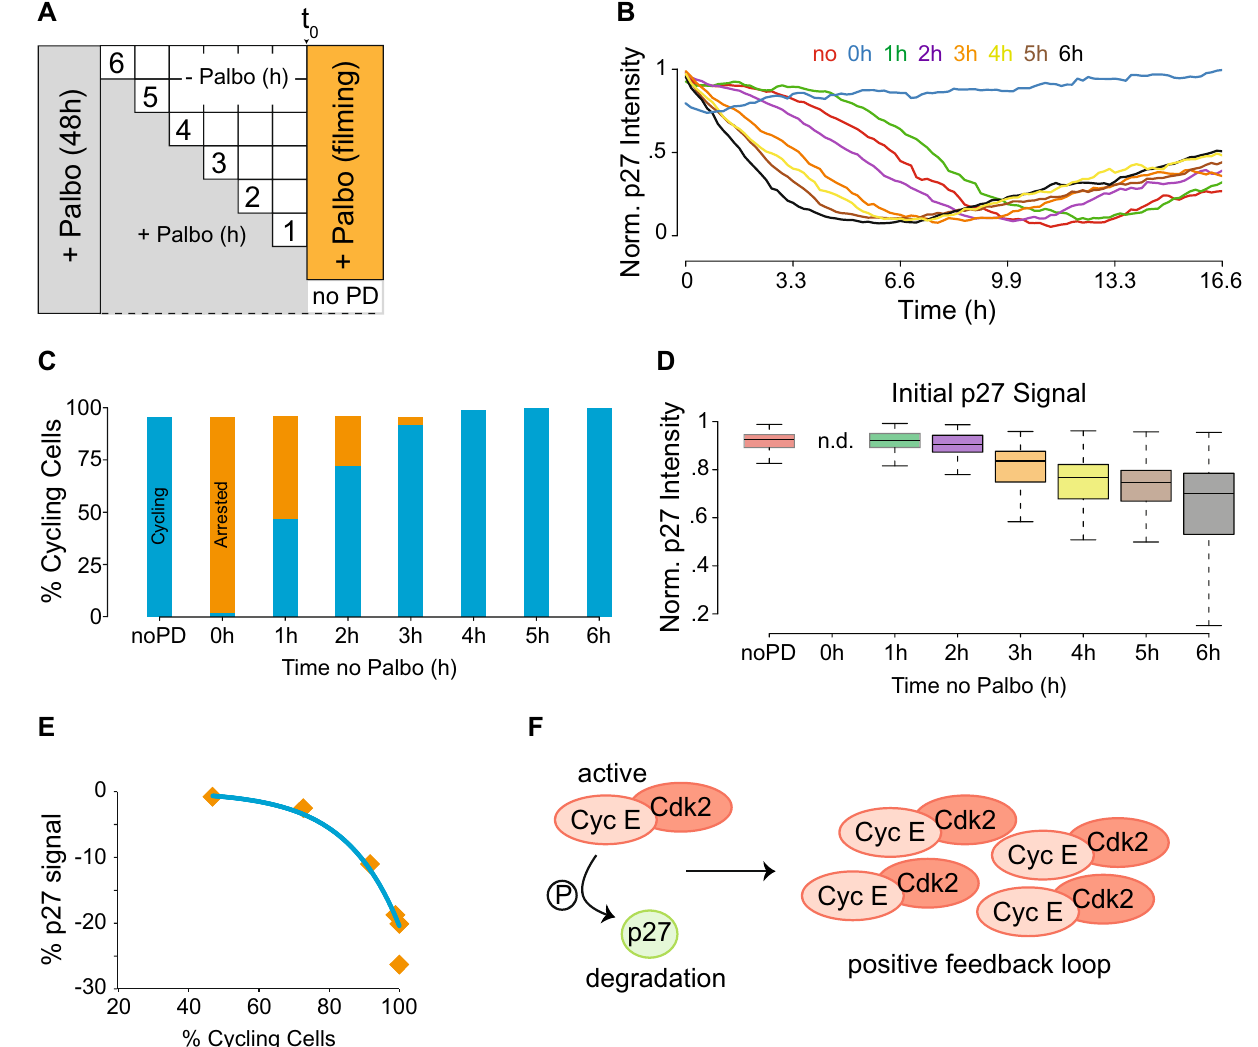
Figure 2. Cyclin D:Cdk4/6 is indispensable after the p27-mCherry inflection point. ( A ) Experimental scheme. In short: p27-mCherry cells were treated for 48 h with Palbociclib before Palbociclib was washed out for the indicated time periods. Before cells were subjected to time-lapse microscopy, fresh Palbociclib was added to all cells but a control sample. Cells were recorded for 20 h, their eGFP and mCherry signals computed to visualize the p27-inflection point. ( B ) An average p27-mCherry signal over 10 time-points for each treated sample is visualized. Note: a time-dependent p27-inflection point is demonstrated. ( C ) Bar graph, grouping all cells from A into cycling (blue) and not cycling or arrested (orange). Interestingly, cells release from 48 h of Palbociclib linearly. ( D ) Box plot visualizing the initial (first 3 time points) p27-mCherry signal intensity of single cells that committed to cellular division (5% increase in H2B-eGFP signal) and its change over time. ( E ) The percentage of cycling cells per time point of no Palbociclib is negative exponentially correlated to the drop in initial p27- mCherry signal. ( F ) Model: The phosphorylation of a relatively small number of p27 proteins is sufficient to induce a positive feedback loop leading to irreversible Cdk2 activation and cell cycle commitment (adapted from ref. 8